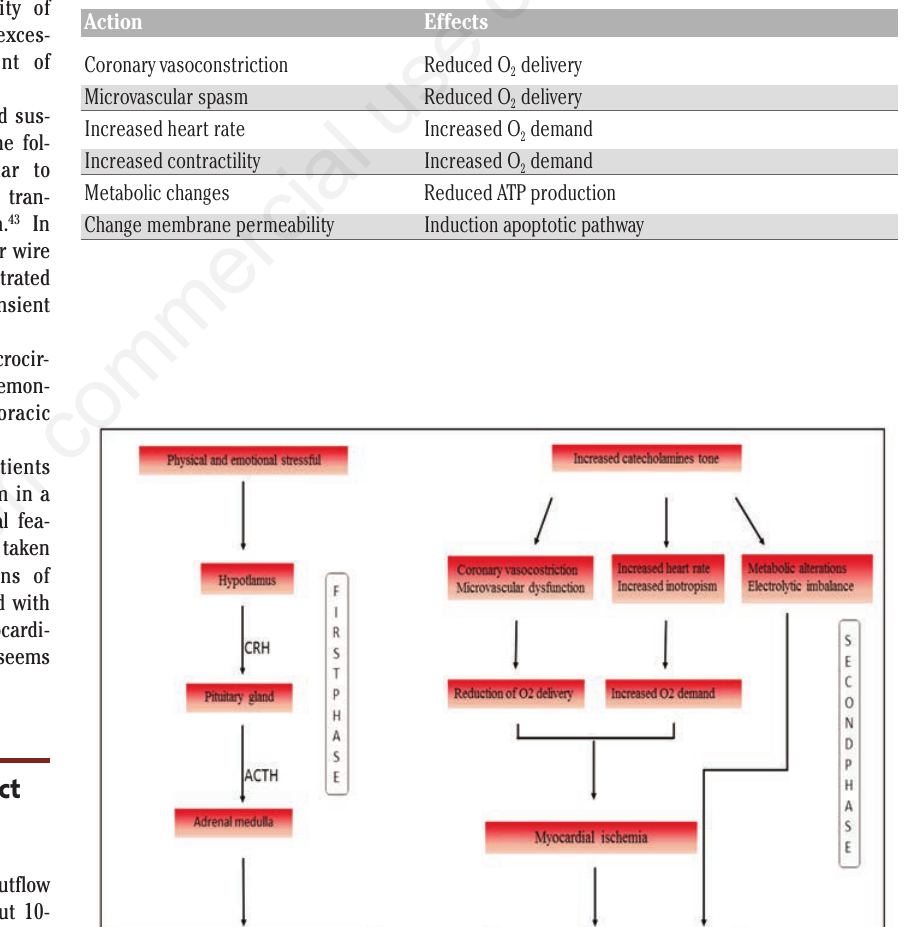
Table 3. Mechanism of catecholamines induced cardiotoxicity.